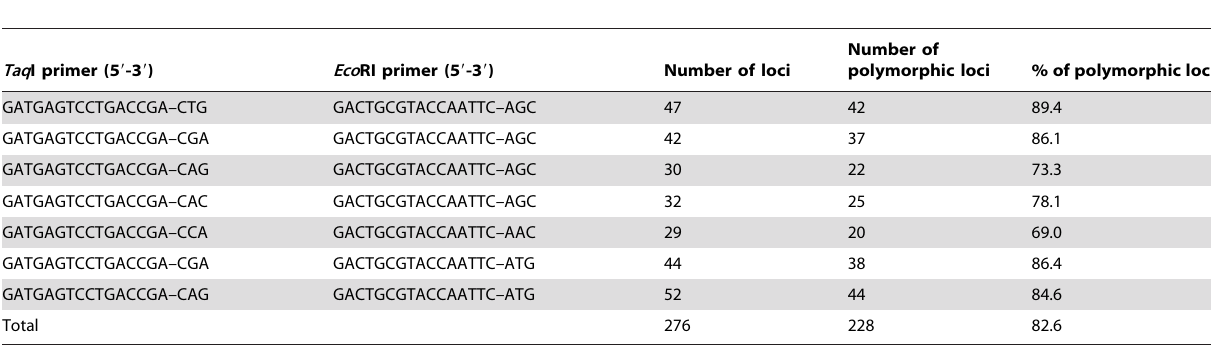
Table 3. Primer combinations used for the AFLP selective amplification and numbers of AFLP bands generated in 414 M. antarctica individuals.